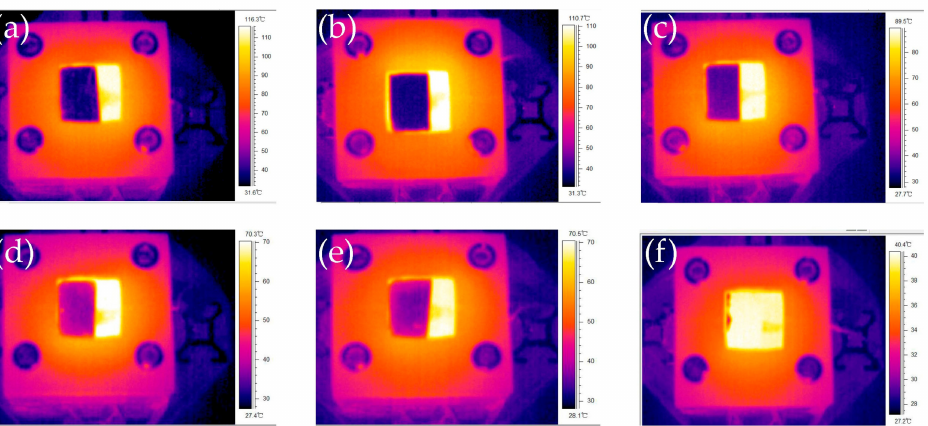
Figure 5. The IR thermal images of heat sink surfaces with different treatments at 40 ◦ C: ( a ) without surface treatment; ( b ) chemical polishing; ( c ) chemical coarsening; ( d ) mechanical shot peening; ( e ) chemical oxidation; ( f ) thermal radia- tion